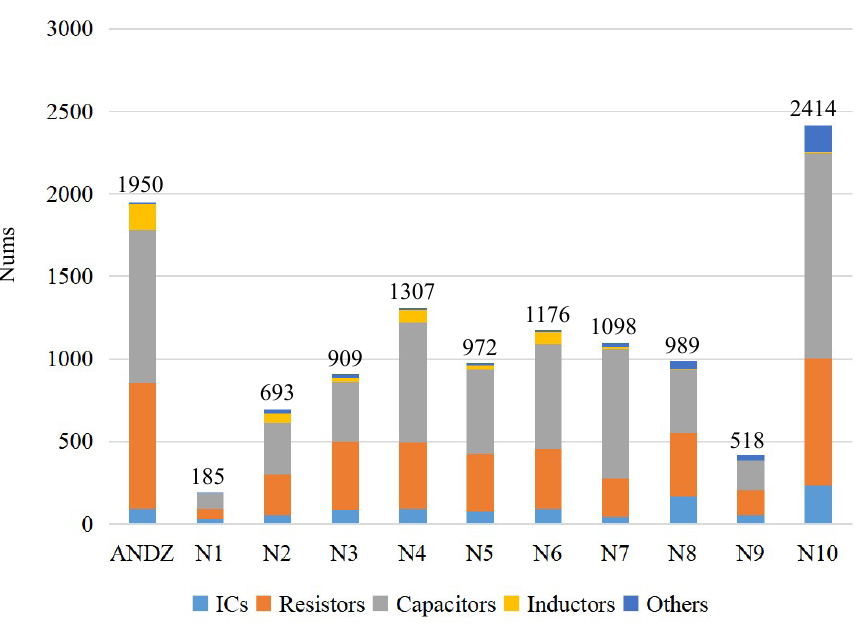
Figure 6. The statistics of resistors, capacitors, inductors, and others for the datasets.